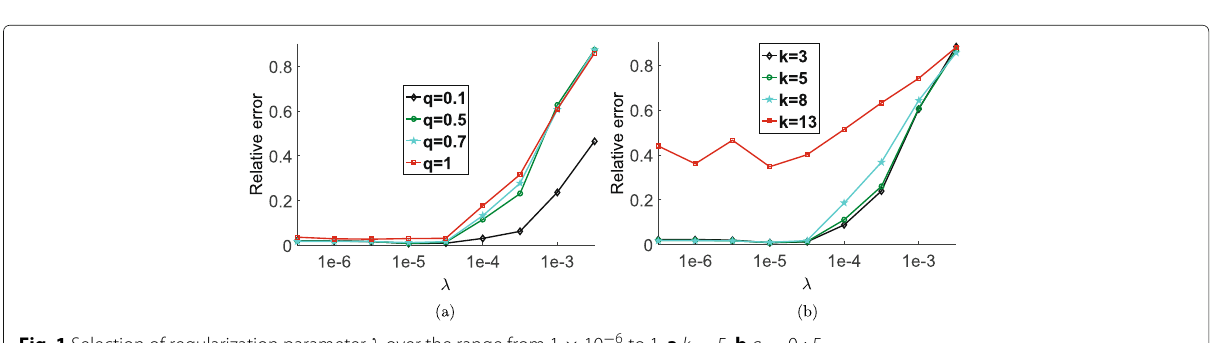
Fig. 1 Selection of regularization parameter λ over the range from 1 × 10 − 6 to 1. a k = 5. b q = 0 :